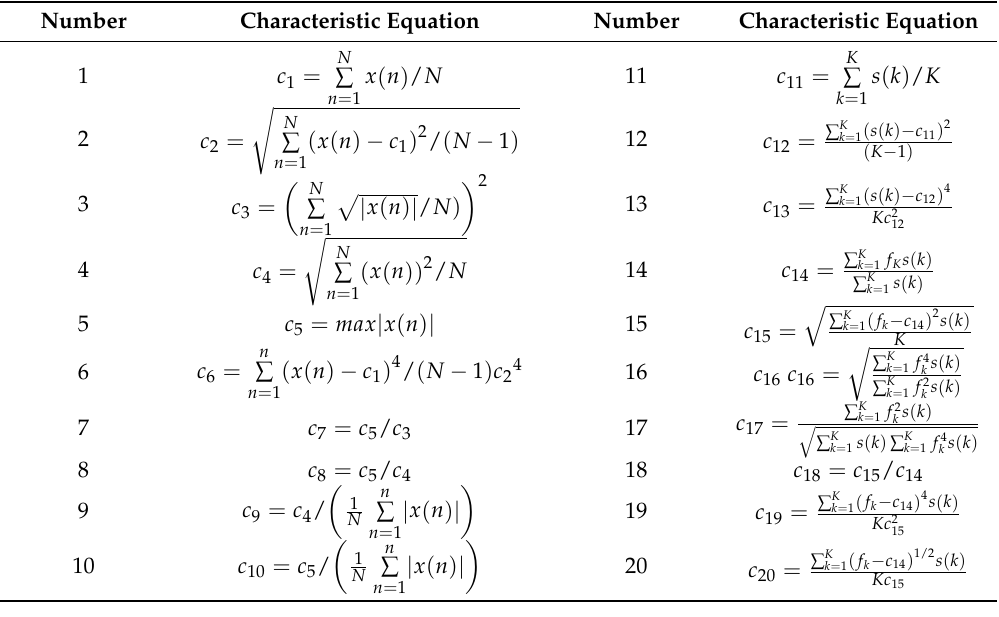
Table 2. Feature extraction in time domain and frequency domain.